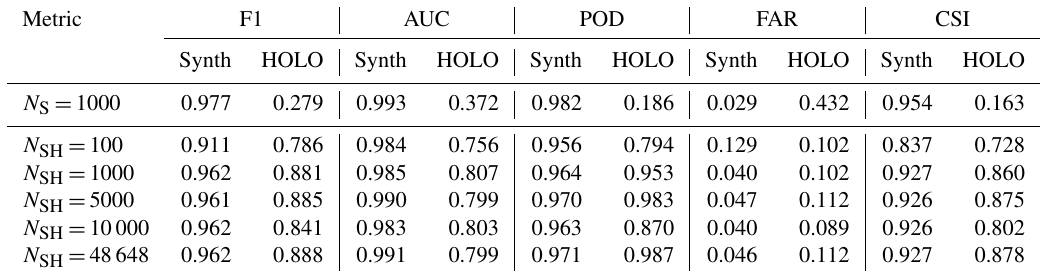
Table 1. Several metrics are listed for each model and were computed on the synthetic (Synth) and HOLODEC (HOLO) test data sets for mask and particle detection (binary) predictions, respectively. The values of POD and CSI reported for mask prediction used the probability threshold which maximized